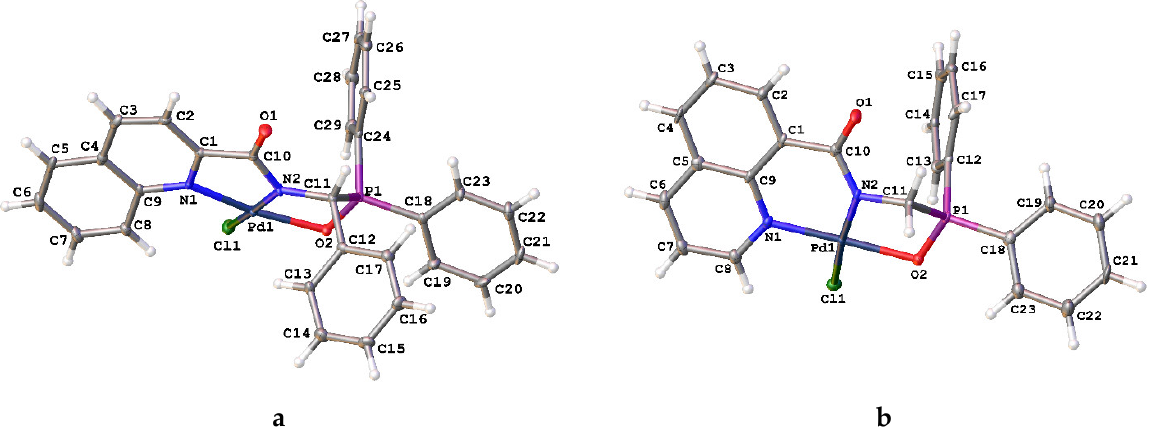
Figure 4. Molecular structures of complexes 5 ( a ) and 7 ( b ). The solvate dichloromethane ( 5 ) or chloroform ( 7 ) molecules as well as the second symmetry-independent molecule of complex 7 are omitted for clarity. For the selected bond lengths and angles, see Table S1 in the SI.